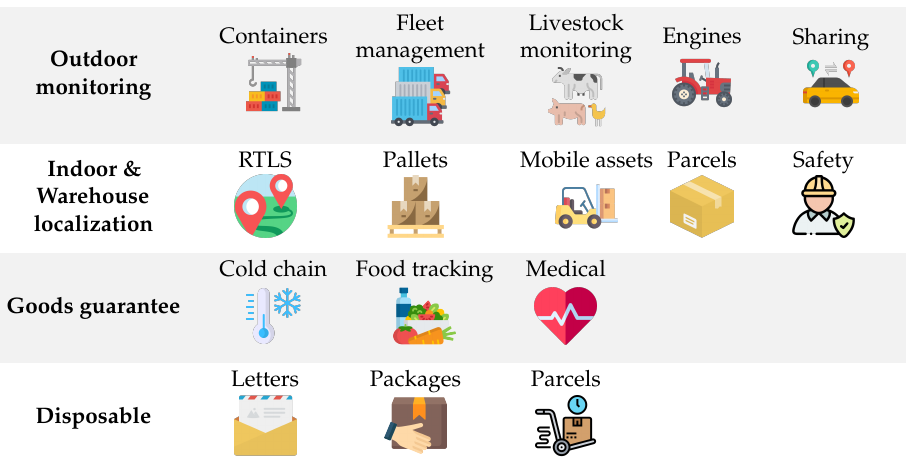
Figure 4. Typical use-cases for industrial indoor and outdoor asset tracking and localization. Be- yond classical indoor and outdoor use-cases, there are a couple of less know topics, e.g., tracing the food chain or tracking disposable items (icons from